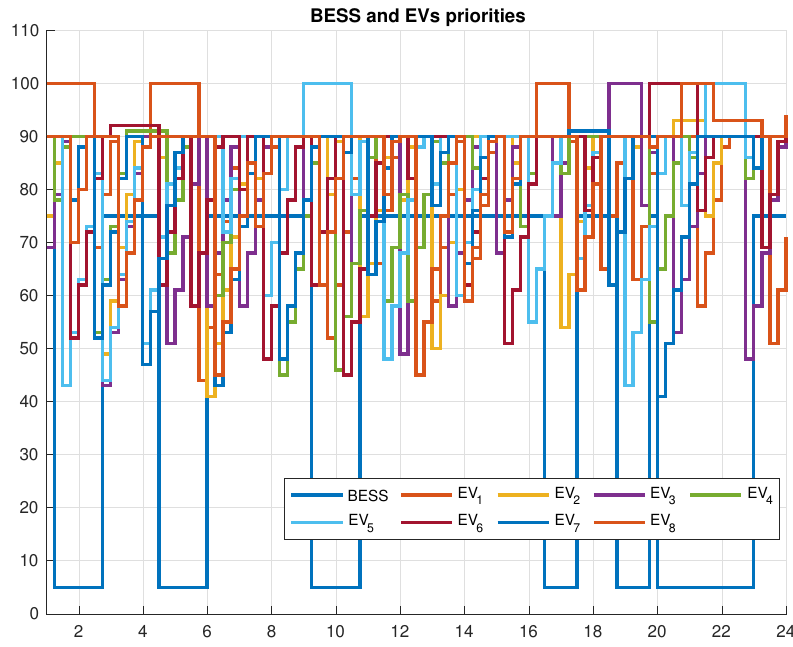
Figure 7. Charging and discharging priority.